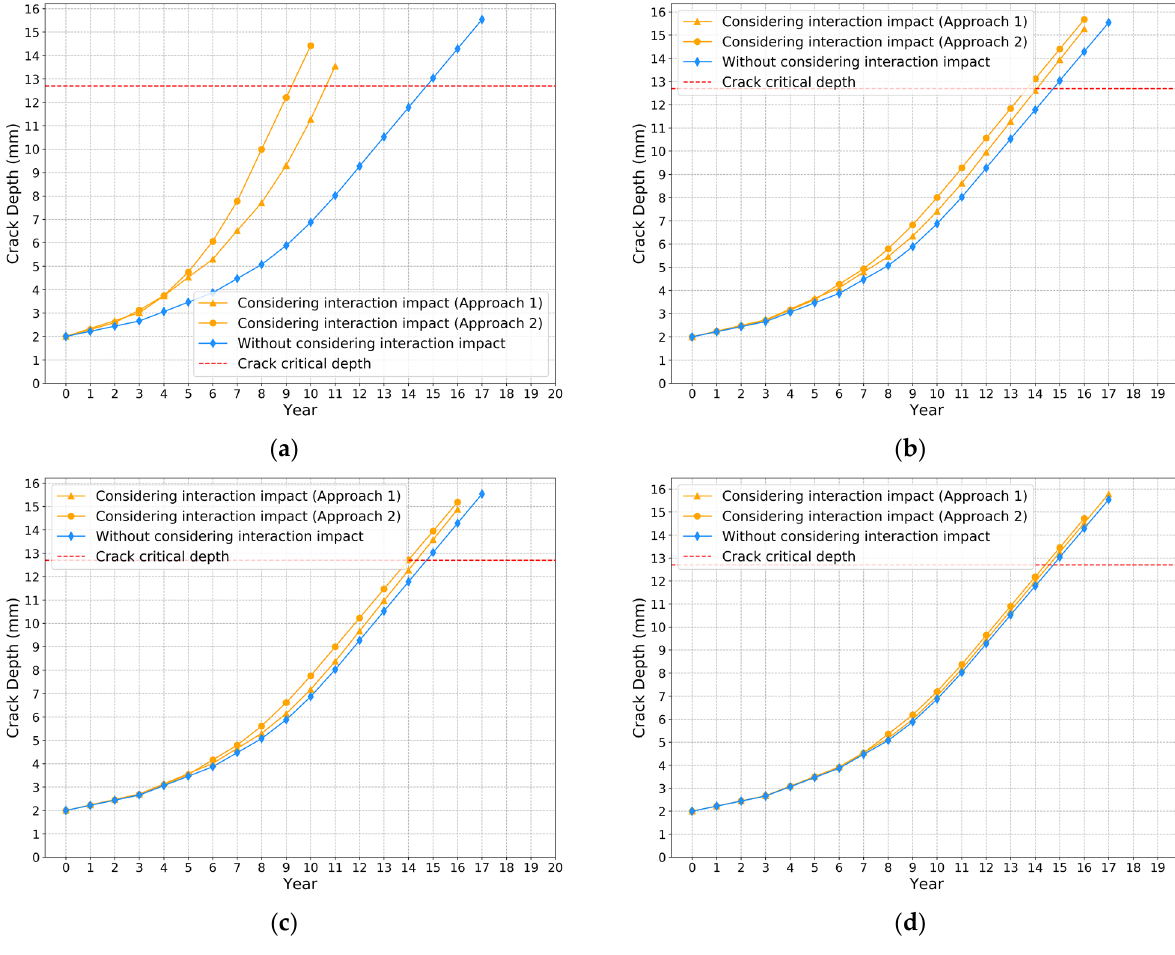
Figure 13. Investigations of the interaction impact on crack depth growth for different axial distances. Axial distance: ( a ) 150 mm; ( b ) 200 mm; ( c ) 300 mm; ( d ) 500 mm.